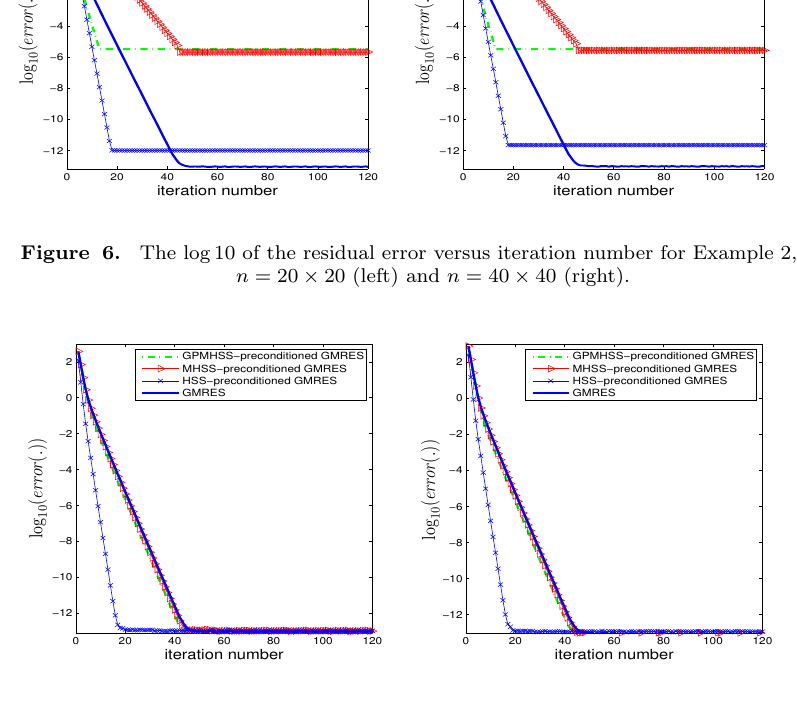
Figure 7. The log 10 of the residual error versus iteration number for Example 2, with n = 20 × 20 (left) and n = 40 × 40 (right).